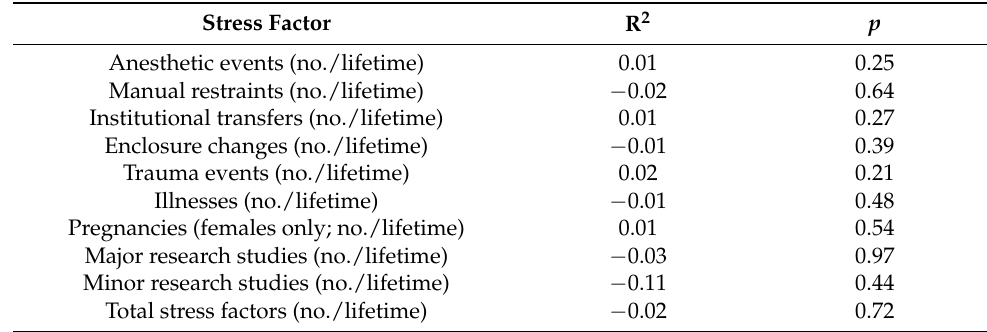
Table 2. The relationship between factors that may influence stress in ring-tailed lemurs ( Lemur catta ) and allostatic load index (0 to 6) calculated for each lemur using six